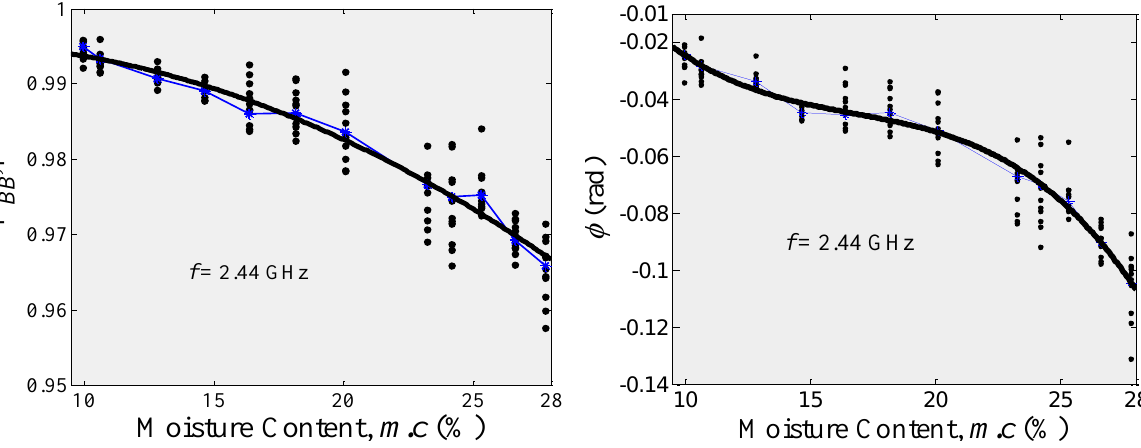
Figure 6. The relationship between reflection coefficient (magnitude, Γ and the moisture content, m.c at 2.44 GHz, 5.81 GHz and 10.02 GHz,